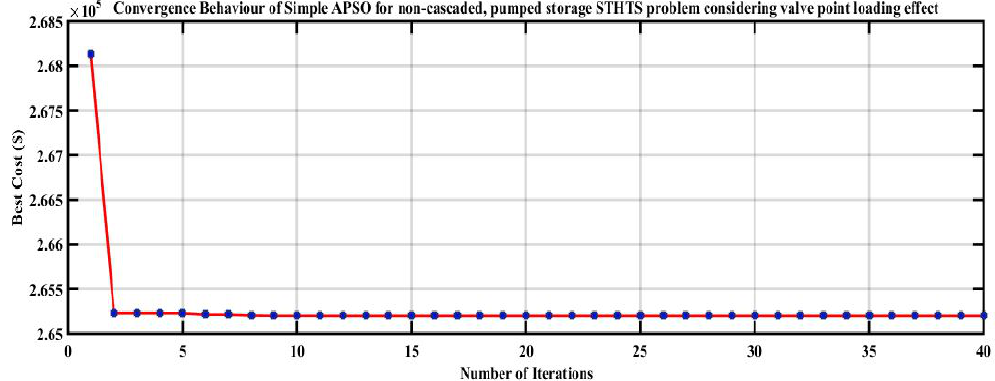
Figure 9. Convergence characteristics of the simple APSO algorithm on the non-cascaded pumped-storage STHTS problem considering valve point